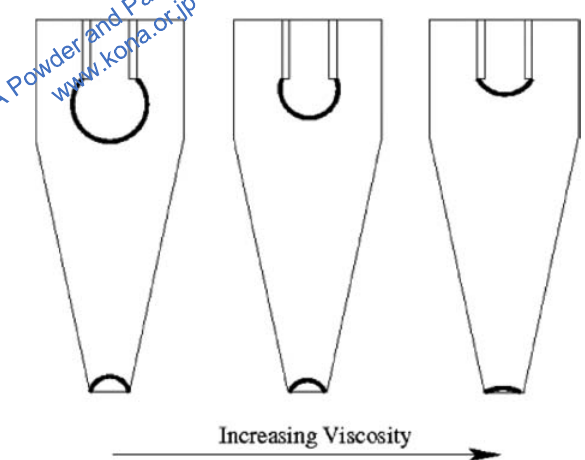
Fig.3 The effect of viscosity on the formation of the air core (Doby et al ., 2008).